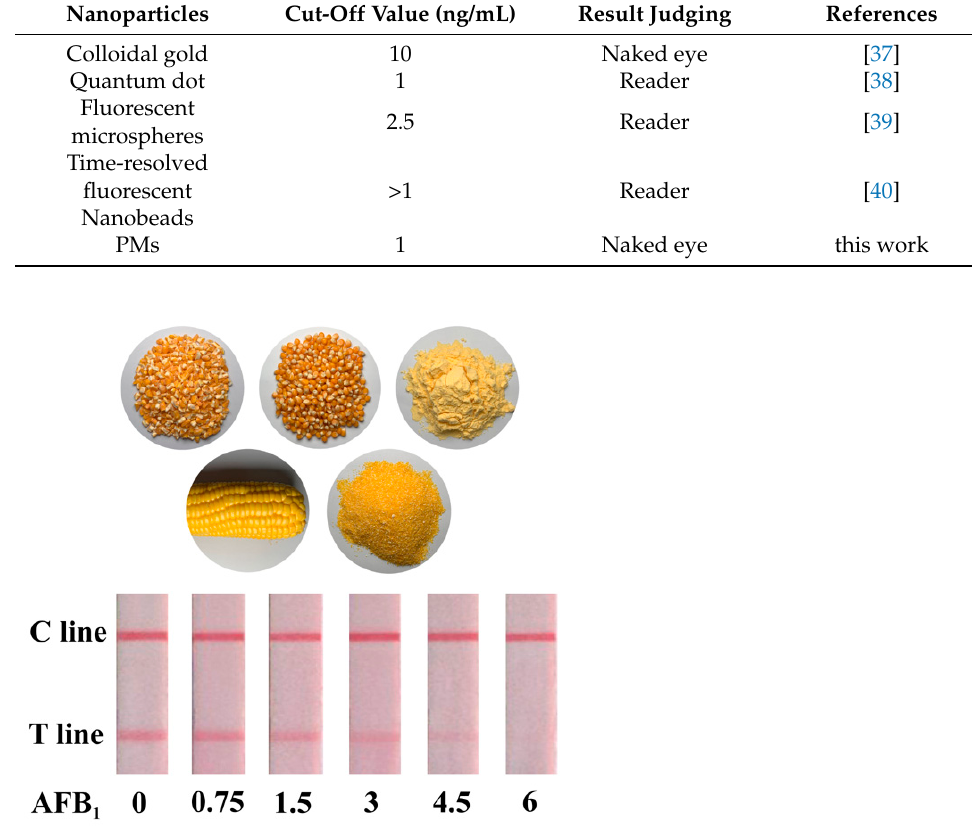
Figure 4. Detection result of AFB 1 in maize samples. vLOD and cut-off value were present by the PMs-ICA, respectively. Table 1. Comparison of performances and convenience of LFICAs for AFB 1 detection.